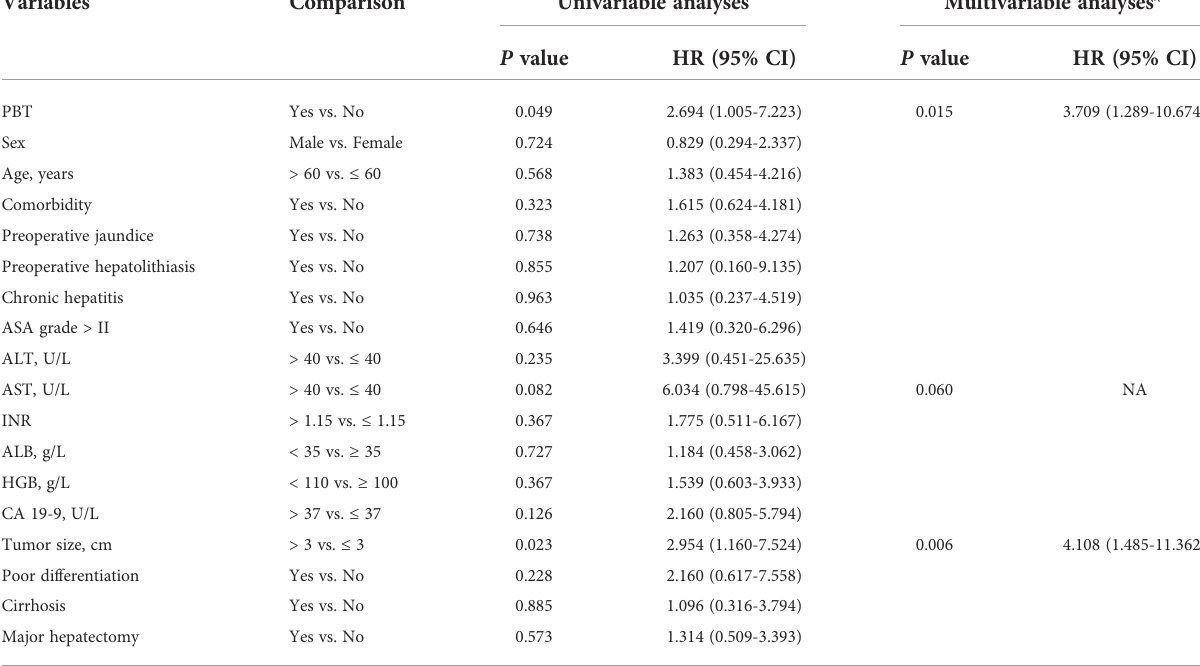
TABLE 4 Univariable and multivariable analyses of independent risk factors for recurrence-free survival among patients with early stage (8th AJCC stage I) pCCA treated with curative resection after propensity score matching. Variables